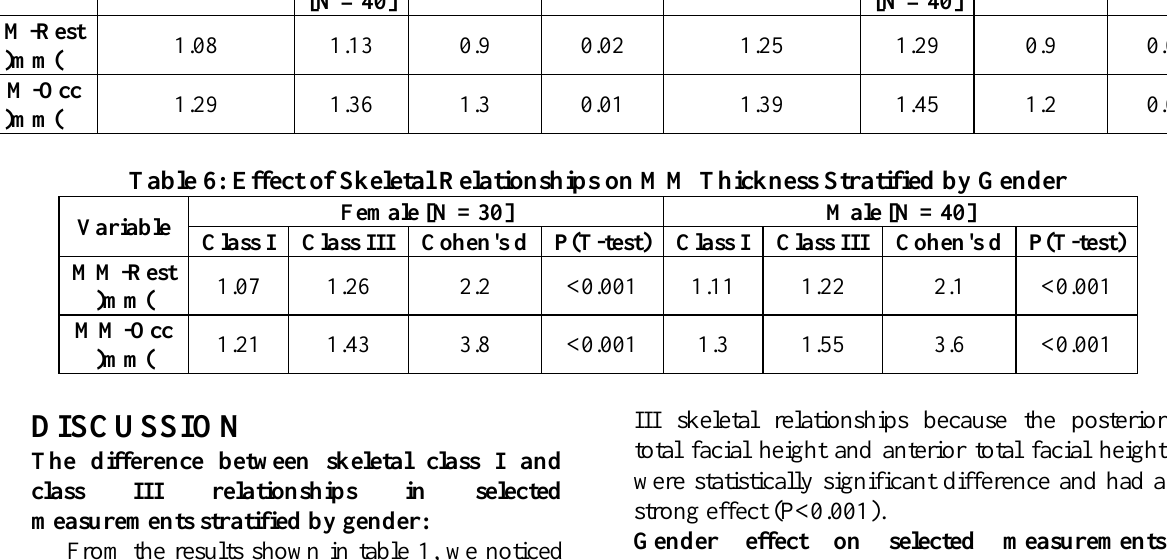
Table 5: Effect of Gender on MM Thickness under Rest and Occlusion Conditions in Each Class